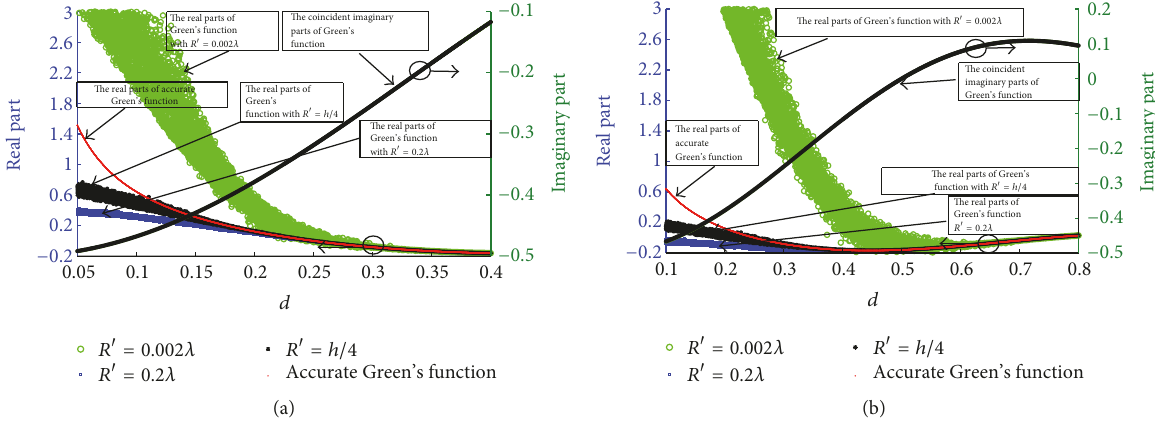
Figure 3: Fitting Green’s functions and accurate Green’s function. (a) ℎ = 0.1𝜆 ; (b) ℎ = 0.2𝜆